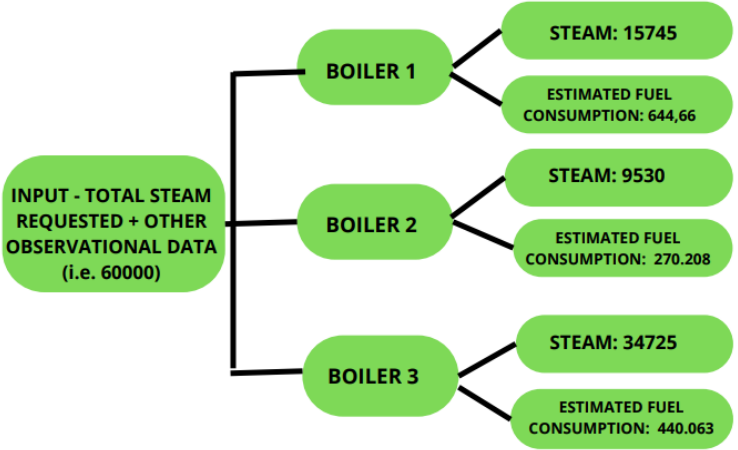
Figure 2. Based on the thermal efficiency of each boiler, the problem to solve is to estimate the optimum fuel required for each boiler while ensuring overall steam production meets the demand. Source: Authors.